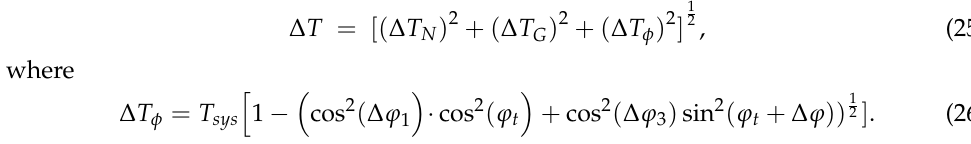
Figure 13 is a block diagram of the multiplicative analog complex correlator applied to the interferometric microwave radiometer architecture [31]. It consists of a power splitter, 3 dB orthogonal coupler, mixer, and differential amplifier.